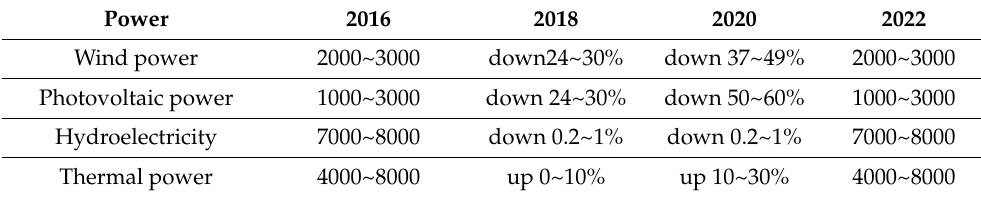
( c ) Figure 8. Forecasted price curves for hydrogen energy equipment from 2020 to 2050. ( a ) electrolytic cell; ( b ) hydrogen storage tank; ( c ) fuel cell.